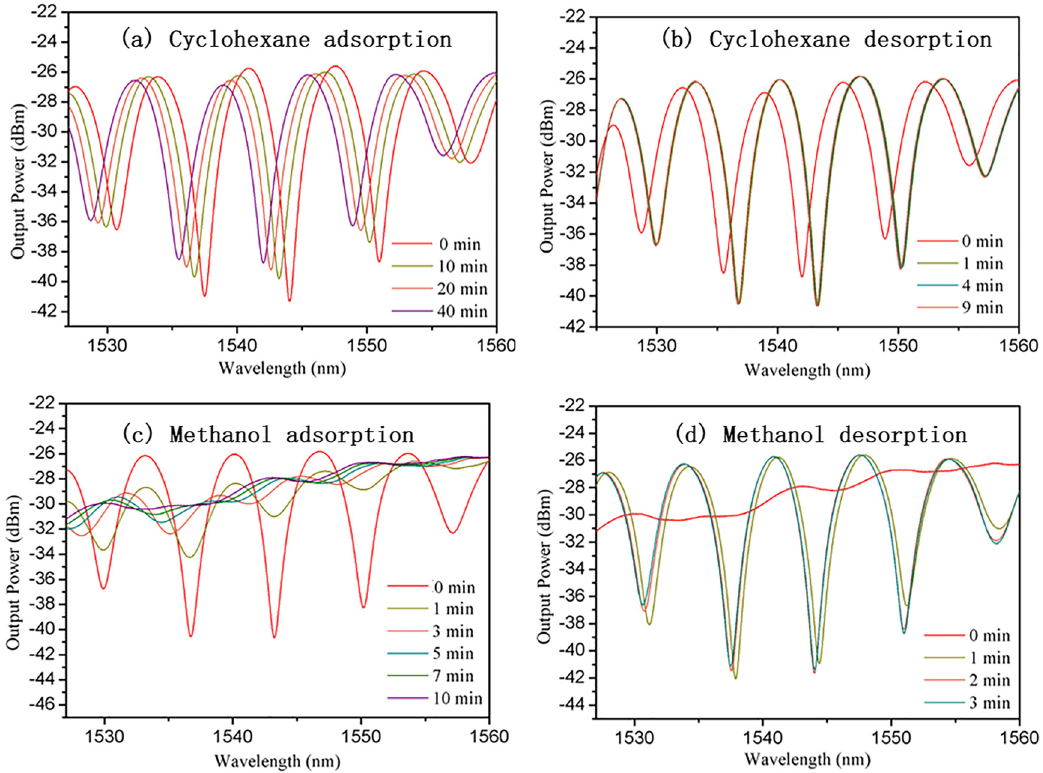
Figure 6: The real-time spectral change of fiber Mach – Zehnder interferometer (MZI) in monitoring the adsorption and desorption of